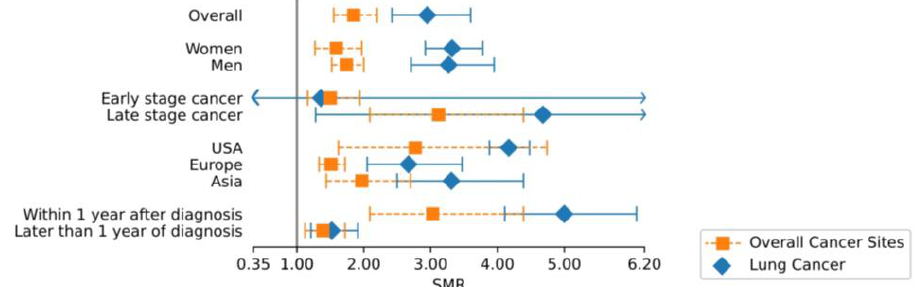
Figure 3. Comparison of overall and subgroup SMR of lung vs. all other cancer sites. Abbreviations: SMR, standardized mortality ratio; CI, confidence interval. Exact values of SMR and CI are indicated separately.